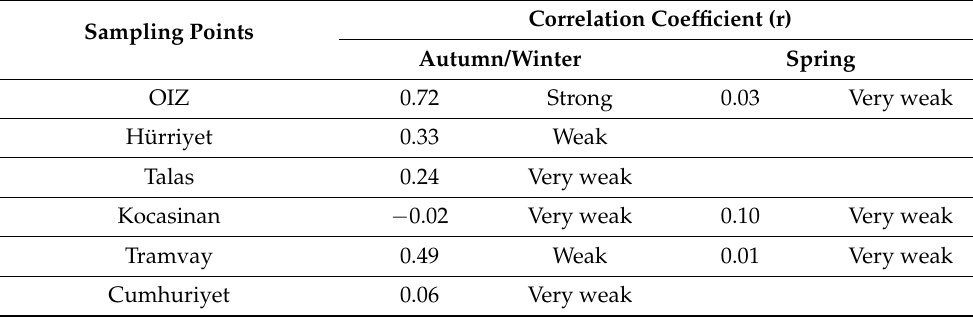
Table 2. Correlation coefficients between PM 10 and inversion intensity.